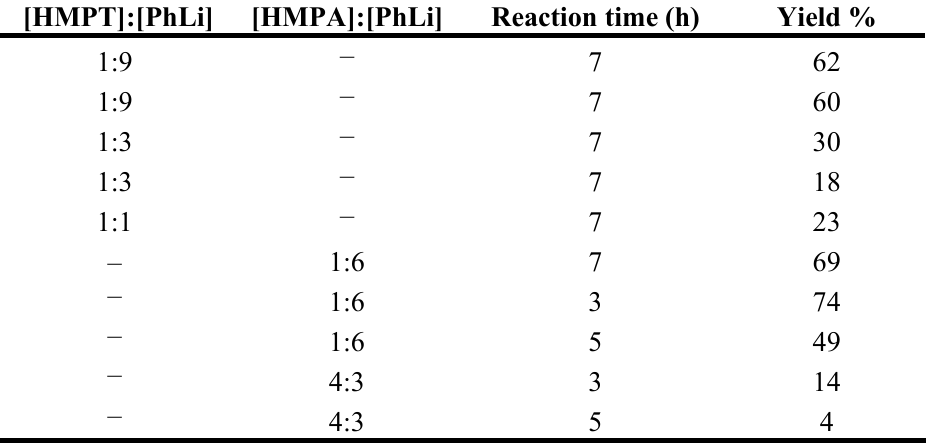
Table 2. Effects of phosphoroamides on the formation of 3-propyl-1,3-diphenylpropanone